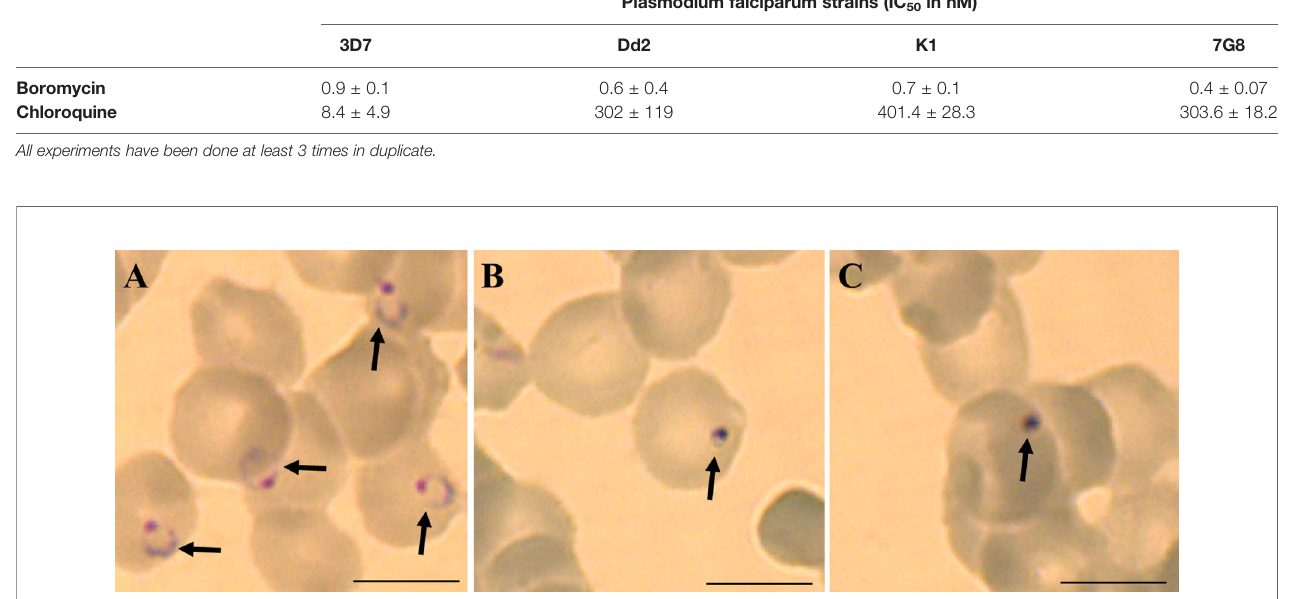
FIGURE 3 | Representative micrographies of P. falciparum infected erythrocytes stained with Giemsa: (A) untreated ring stage parasites after 6 hours, (B) parasites strain 3D7 treated with 1 nM of boromycin for 6 h and (C) parasites strain Dd2 treated with 1 nM of boromycin for 6 h. Arrows: parasites. Scale bar: 10 µm.